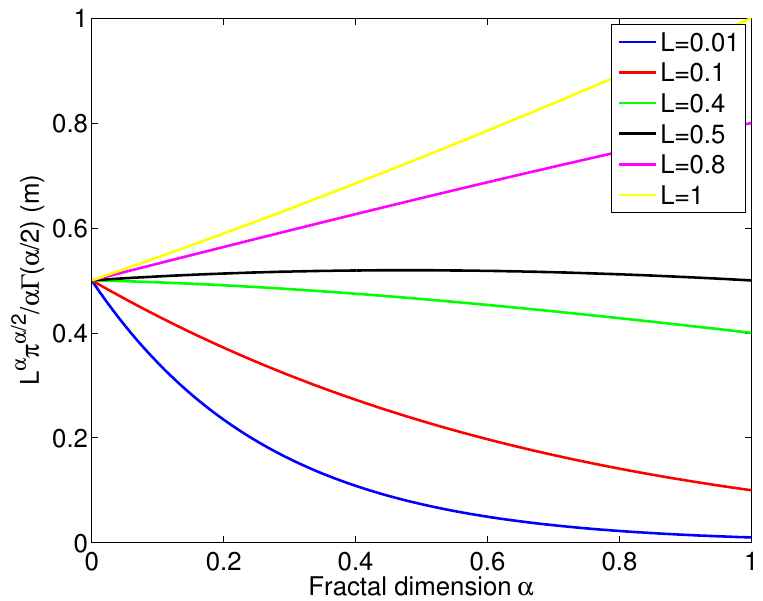
Figure 2. Variation of the equivalent thickness ( L α π α /2 / α Γ ( α /2) in the fractal material as a function of the fractal dimension.